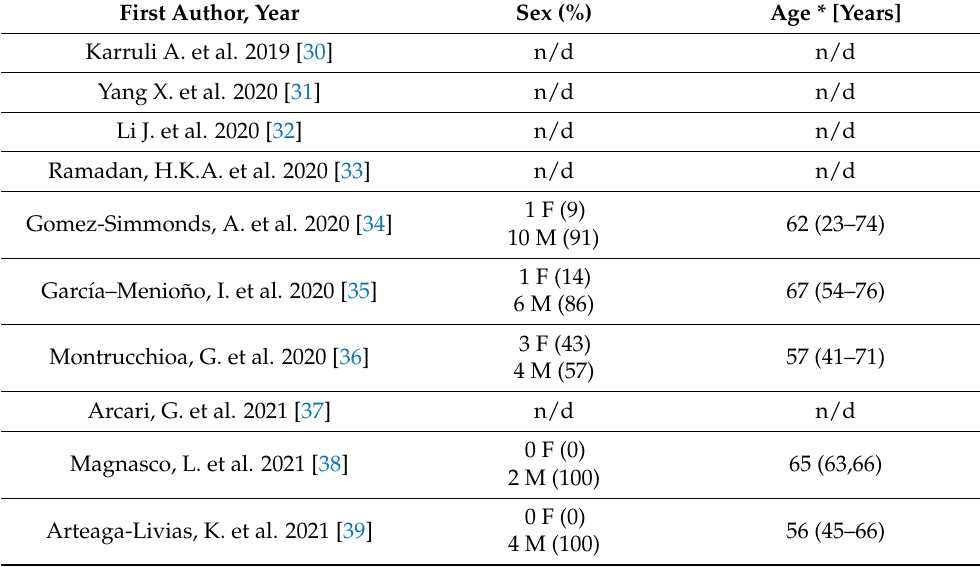
Table 4. Demographic and social data.